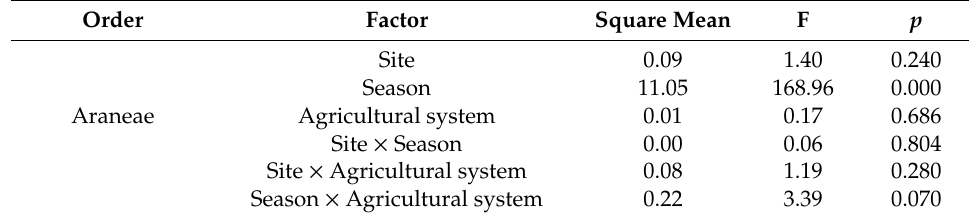
Table 3. Influence of agricultural system, season and site on the abundance of arthropod populations. The values result from the factorial analysis of variance when comparing these factors. Values were √ transformed to (x + 1) before the